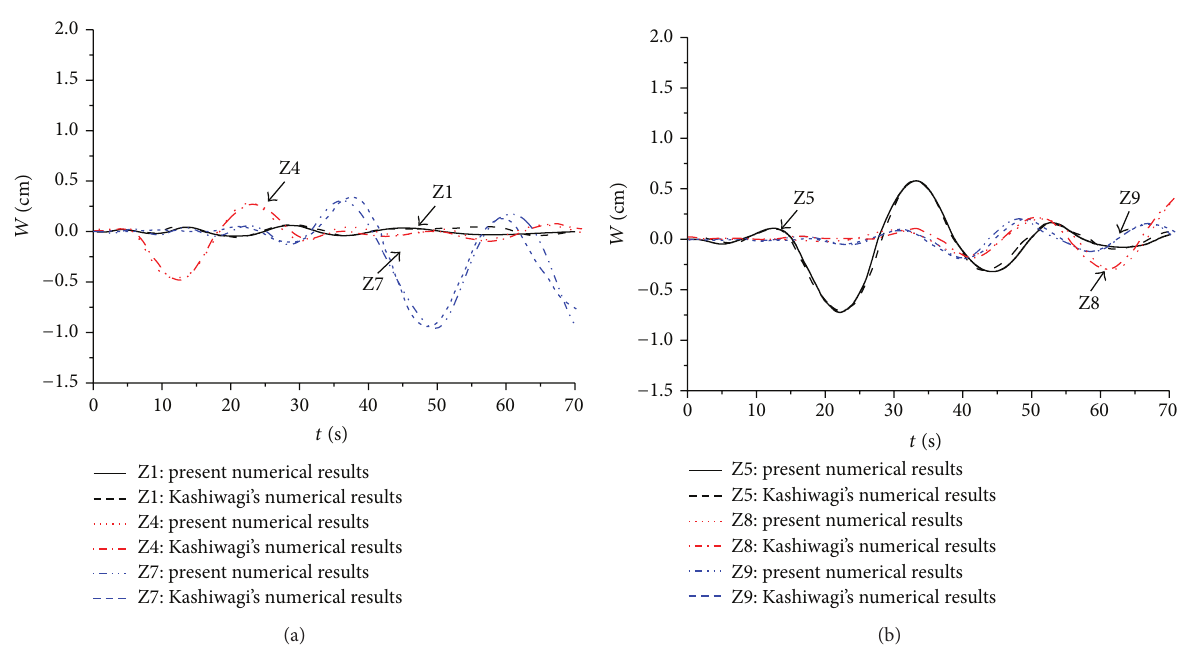
Figure 10: Time histories of the vertical displacement subjected to landing of